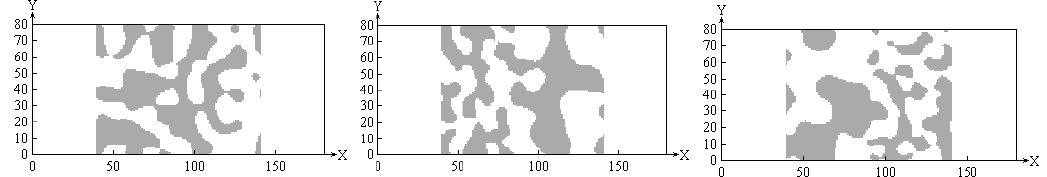
Figure 3. Slice images of Filter 1 ( left ); Filter 6 ( middle ); and Filter 7 ( right ).